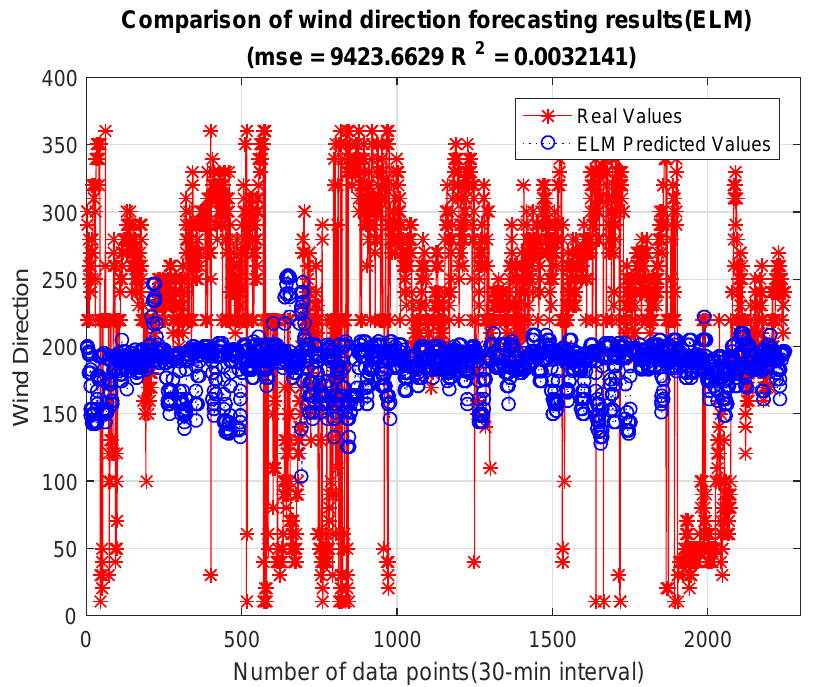
Figure 19. The portraits of comparison of wind direction forecasting results (ELM) in OSWFs in Yangshan port, Shanghai from 22 August 2017 to 22 August 2018 (number of predicted data pieces is